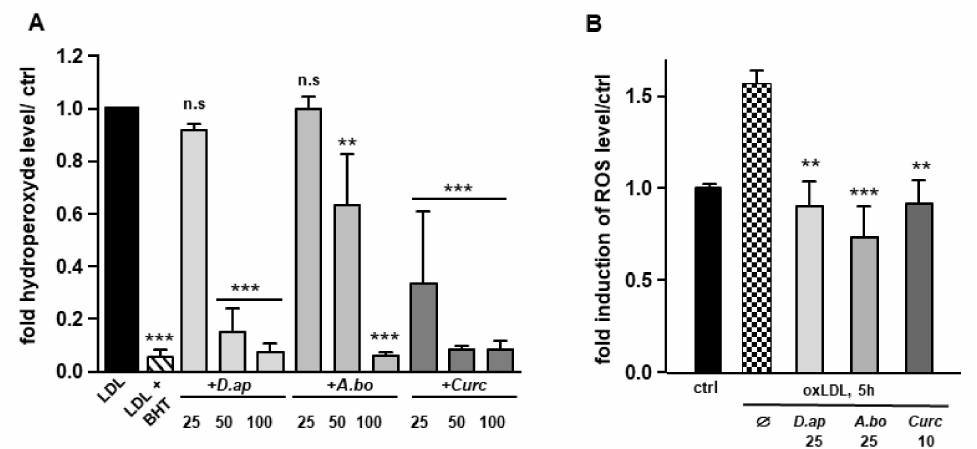
Figure 1. D. apetalum and A. borbonica extracts exhibit antioxidant properties. Antioxidant properties of various concentrations of polyphenol-rich extracts from D. apetalum and A. borbonica or curcumin were evaluated on LDL oxidation and oxLDL-induced intracellular ROS production in HMEC-1 cells. ( A ) Fold increase of hydroperoxide formation assayed by xylenol orange test. LDL are incubated for 2 h at 37 ◦ C with 4 µ M CuSO 4 with or without plant extracts. Hydroperoxide formation was followed by colorimetric reaction, using xylenol orange; ( B ) inhibition of oxLDL-induced intracellular ROS production. HMEC-1 cells were pre-treated with plant extracts 2 h before addition of oxLDLs for 5 h. increase in intracellular ROS was quantified using H 2 DCFDA fluorescent probe and expressed as fold of induction of ROS levels compared with that of control (without oxLDLs). Results are expressed as means ± SEM of at least 3 independent experiments. ** p < 0.01, *** p < 0.001, compared to control (ctrl) (LDL) [A]; ** p < 0.01, *** p < 0.001, compared to oxLDLs [B] using one-way ANOVA with posthoc Tukey’s test.